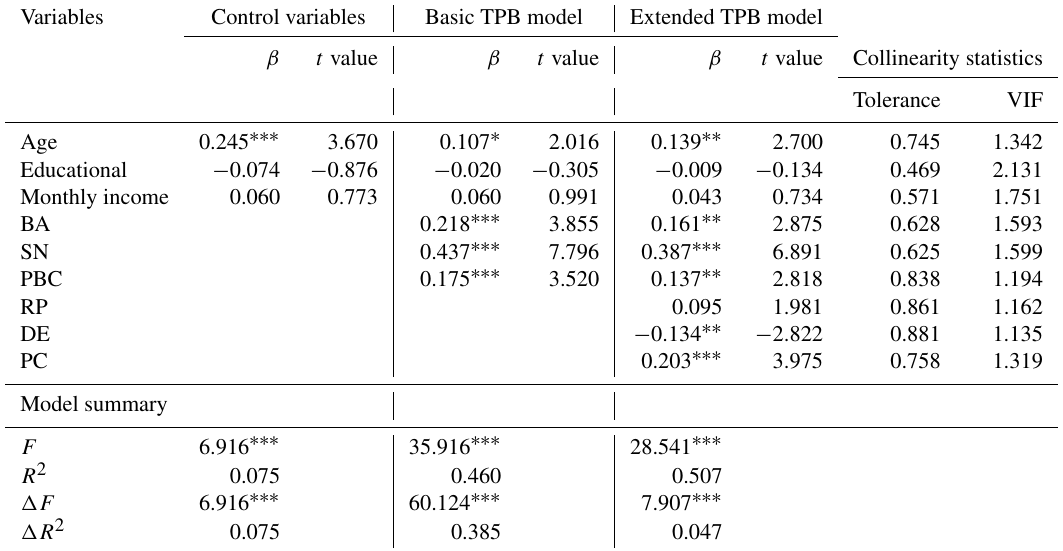
Table 7. Hierarchical regression results.